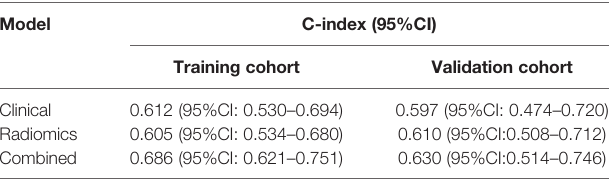
TABLE 2 | The performance of three models for progression-free survival prediction in patients treated with osimertinib.